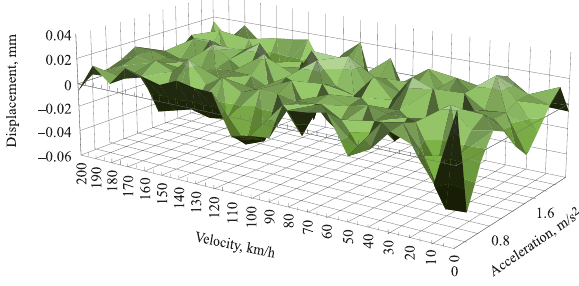
Fig. 1. Max displacements of the plate with different accelerations and